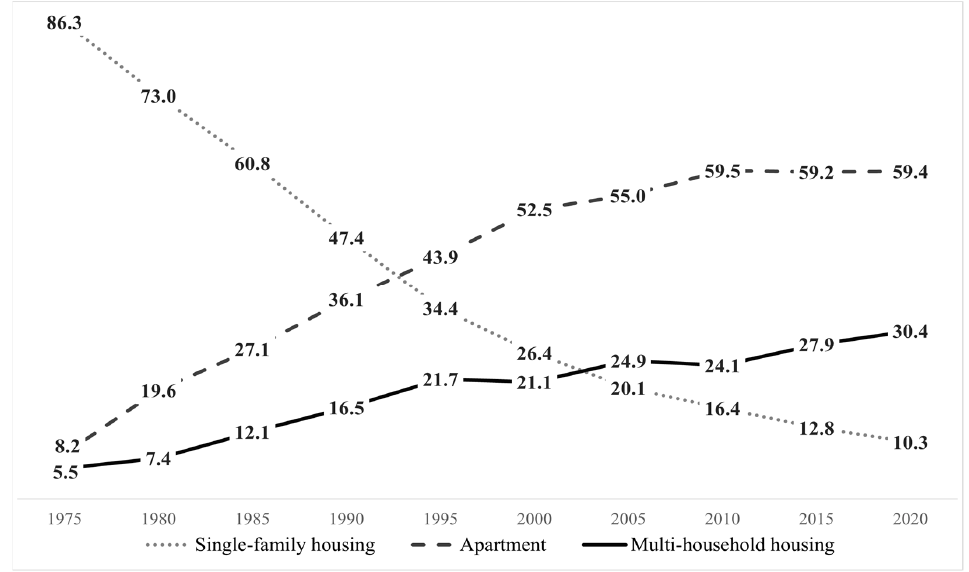
Figure 1. Housing proportion by type in Figure 1 . Housing proportion by type in Seoul.